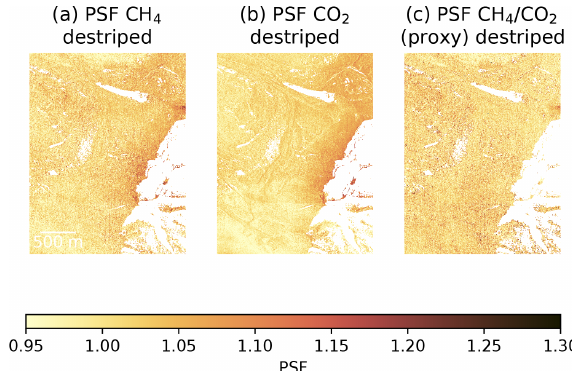
Figure 7. Example of the effect and necessity of the proxy method from flight line ang20170823t180156. In panel (a) , the destriped is shown. Simply analyzing this image, one could assume PSF CH 4 a diffuse enhancement due to perhaps coal mining activities as this is part of an open-cast coal mine. In panel (b) , the destriped PSF CO is shown. There, a similar enhancement is visible. In panel (c) , the destriped proxy results are shown in which this diffuse enhancement